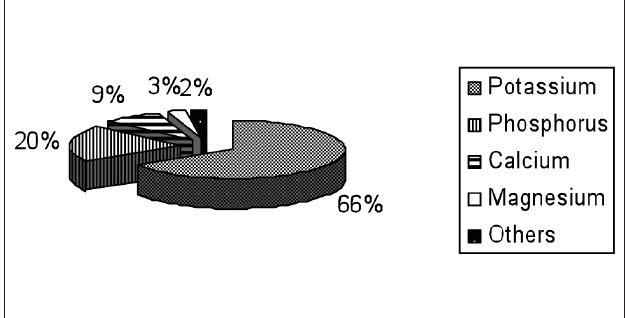
Fig. 1: Percentage distribution of the mineral elements in summer truffle ( T. aestivum ) fruit